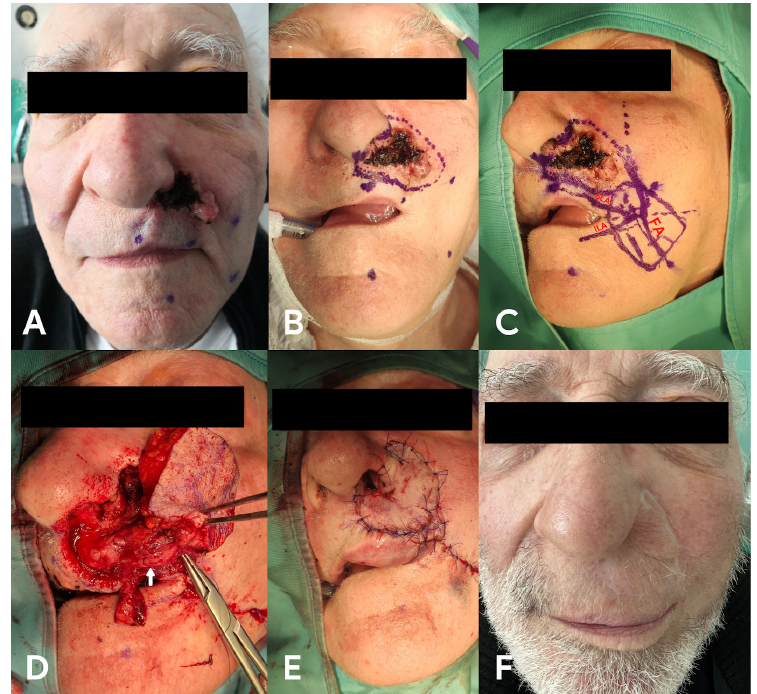
Figure 3. Basal cell carcinoma of the left ala of the nose and left cheek. ( A )—a view of the tumour, ( B )—range of the resection, ( C )—rSLA flap planning, FA—facial artery, SLA—superior labial artery, ILA—inferior labial artery, ( D )—pedicle of the flap (white arrow), ( E ) final reconstruction, and ( F ) patient 12 months after the surgery.